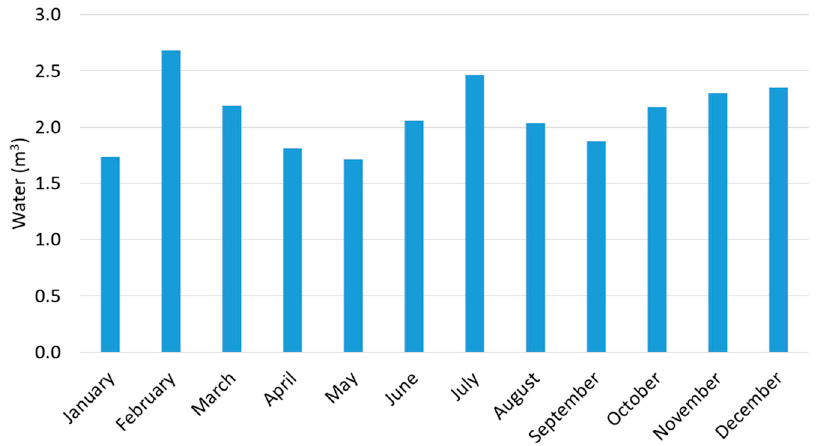
Figure 5. Monthly water consumption of the complete station in 2014.